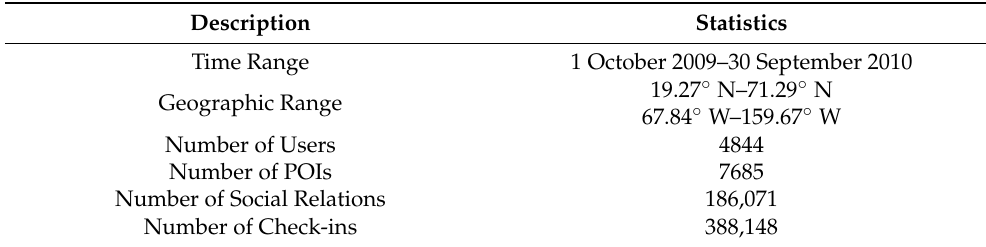
Table 2. Brightkite